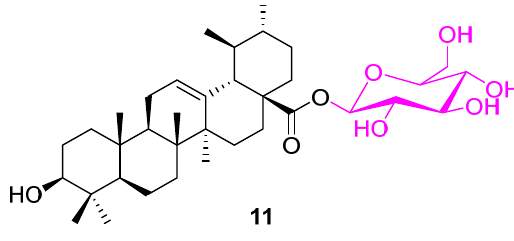
Figure 8. Structure of 11.